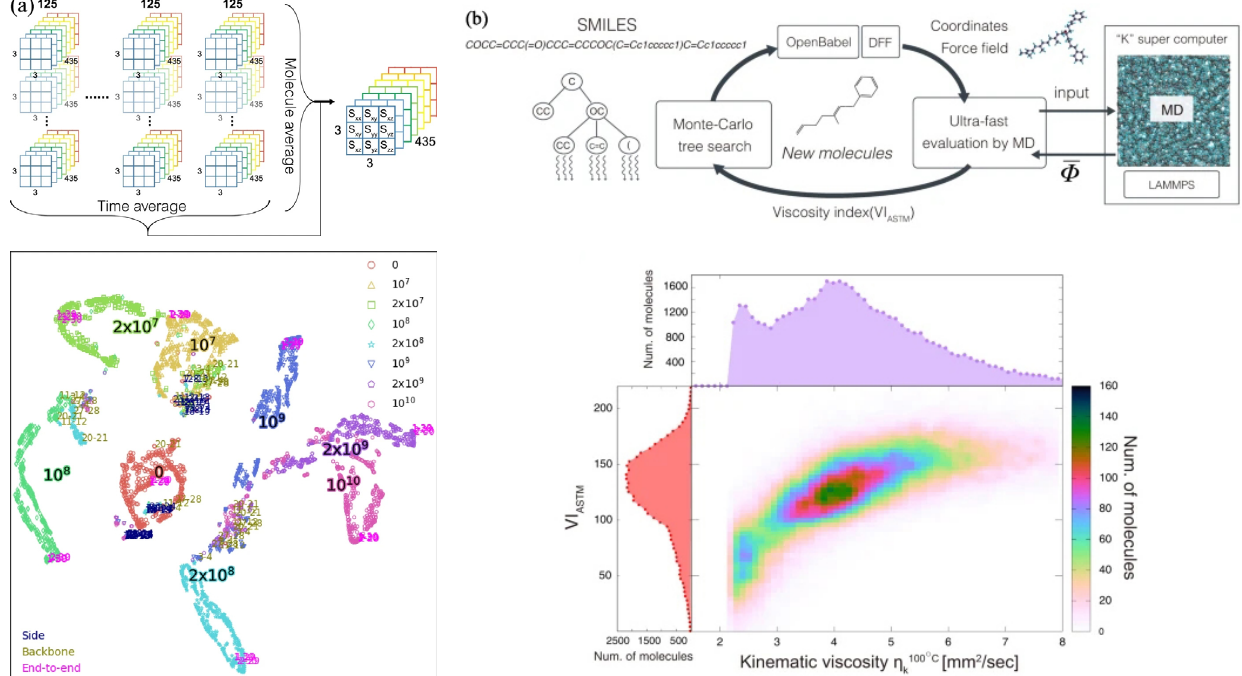
Fig. 58 Molecular dynamics and machine learning methods in EHL simulation [873, 877]. Reproduced with permission from Ref. [873, 877], © The author(s), 2021 and The author(s), 2020,